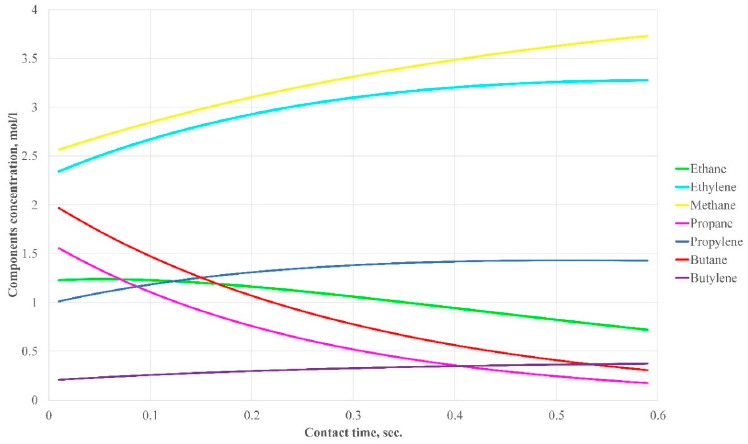
Figure 5. Changes in the concentrations of the components with a reduced contact time.